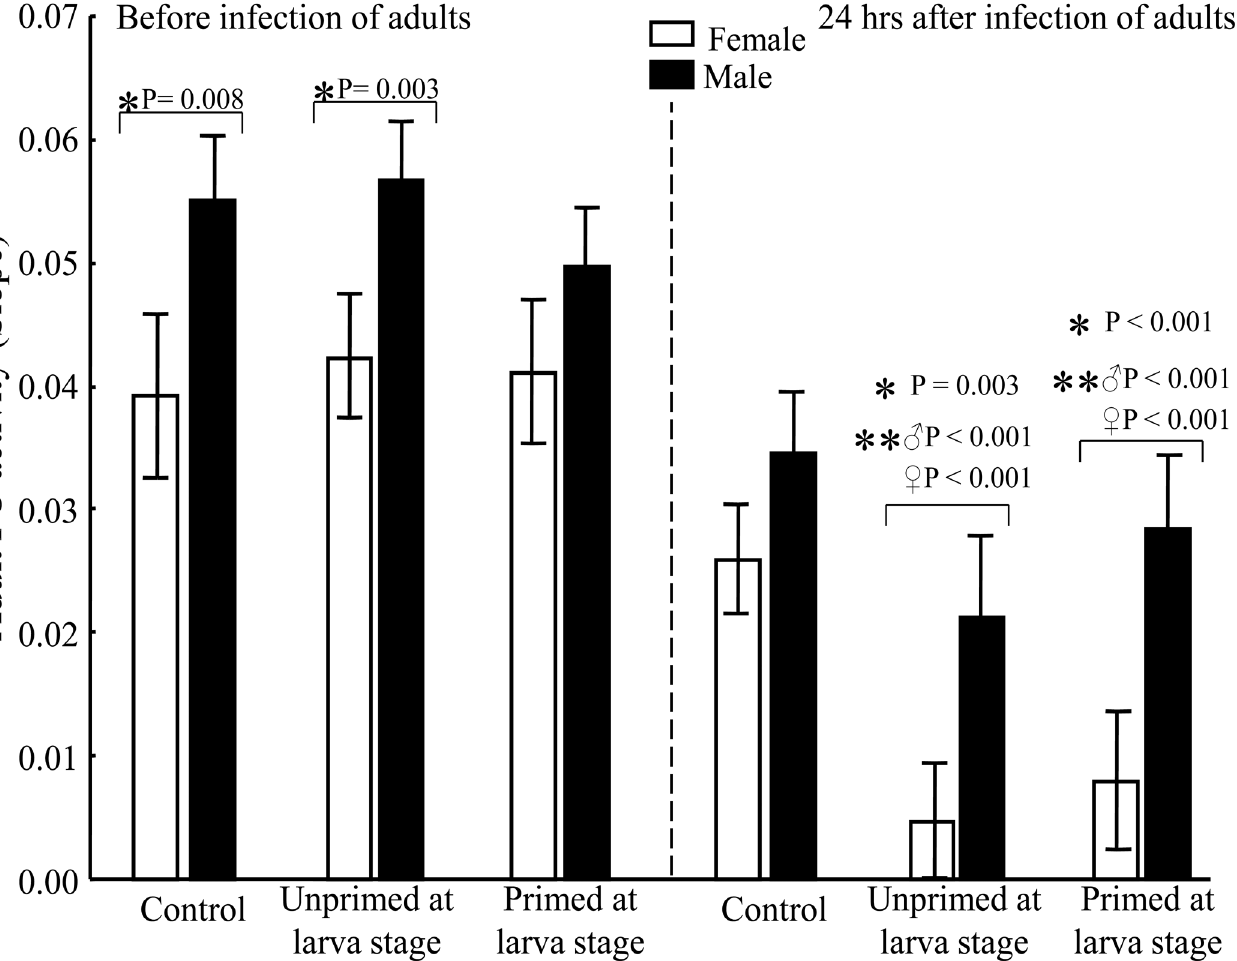
Fig 3. Gender differences for the PO activity. ( * ) indicates a significant difference between genders within a treatment group (C, UnPr, Pr). ( ** ) indicates a significant difference between the measurements before and after infection of adults (for the C group at 24 h post-challenge, the significant difference was only found for males). Number of samples per group before infection: ♀ = 14, ♂ = 24 for C; ♀ = 24, ♂ = 26 for UnPr; ♀ = 18, ♂ = 26 for Pr. Number of samples per group 24 h after infection: ♀ = 30, ♂ = 26 for C; ♀ = 28, ♂ = 14 for UnPr; ♀ = 19, ♂ = 18 for